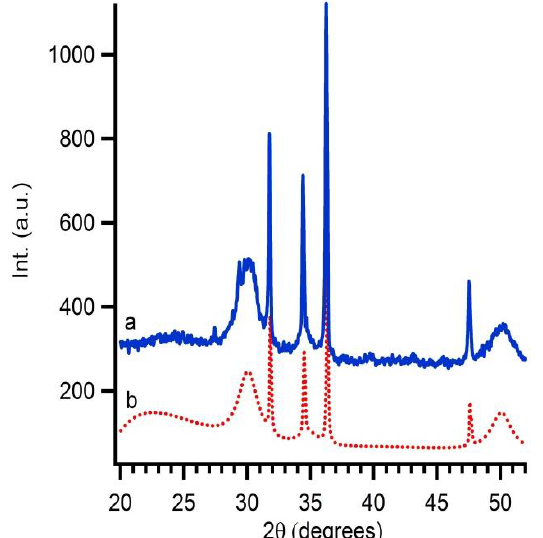
Figure 10. Rietveld refinement of the sample treated at 600 °C with ( a ) the experimental data, sample inclusive internal standard; and ( b ) the calculated